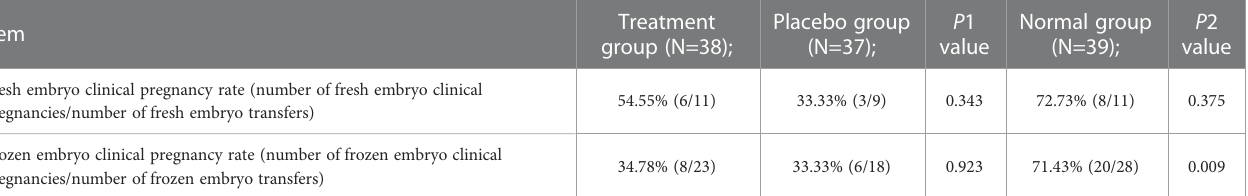
TABLE 4 Comparison of pregnancy outcomes among three groups